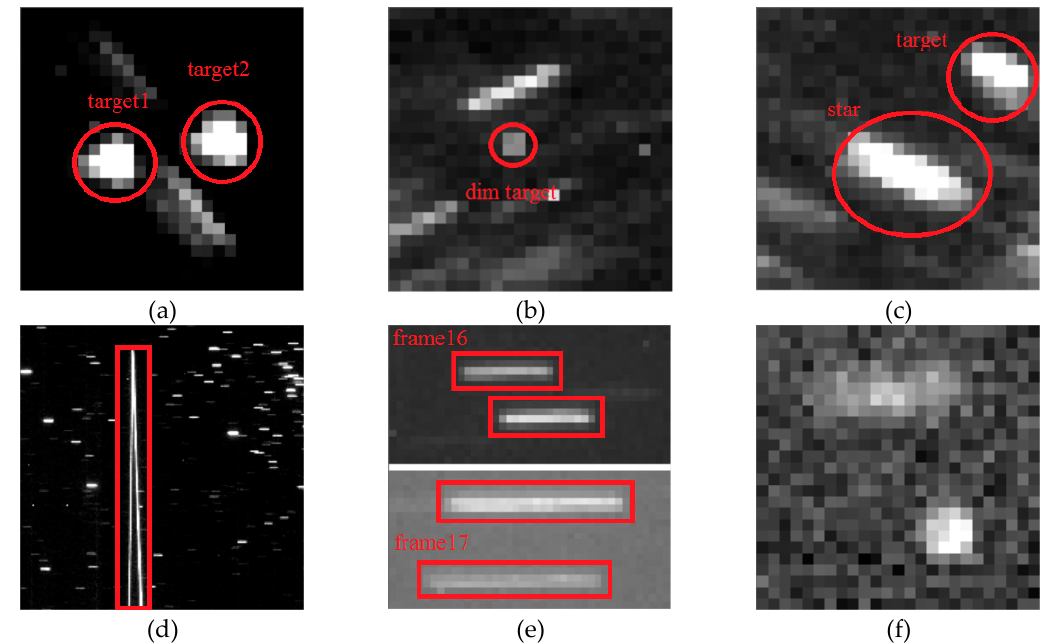
Figure 9. Typical cases of measured data: ( a ) close target; ( b ) dim target; ( c ) targets similar to stars; ( d ) high-brightness and fast-moving disturbing object; ( e ) exposure time change; ( f ) strong moonlight interference.